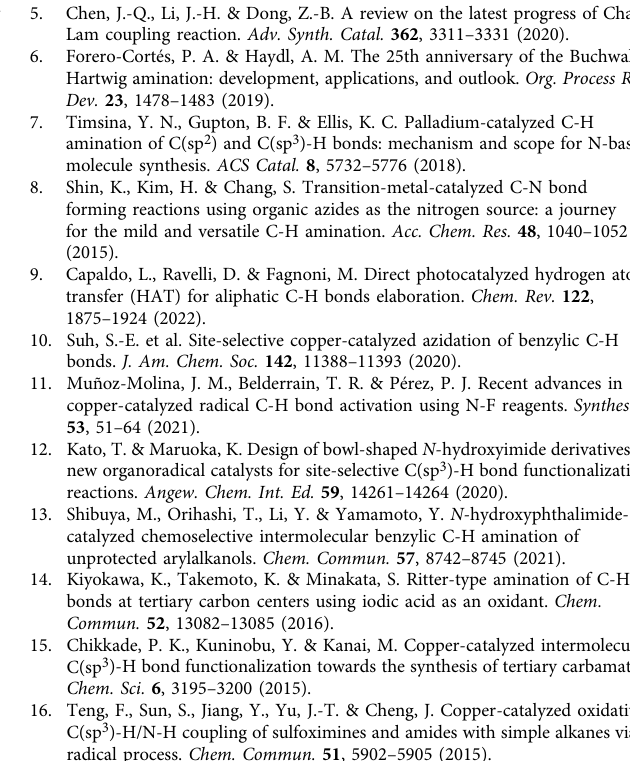
n Bu 4 NBF 4 (0.1 M) and CH 3 CN (3 mL). b Radical trapping experiments. c Proposed